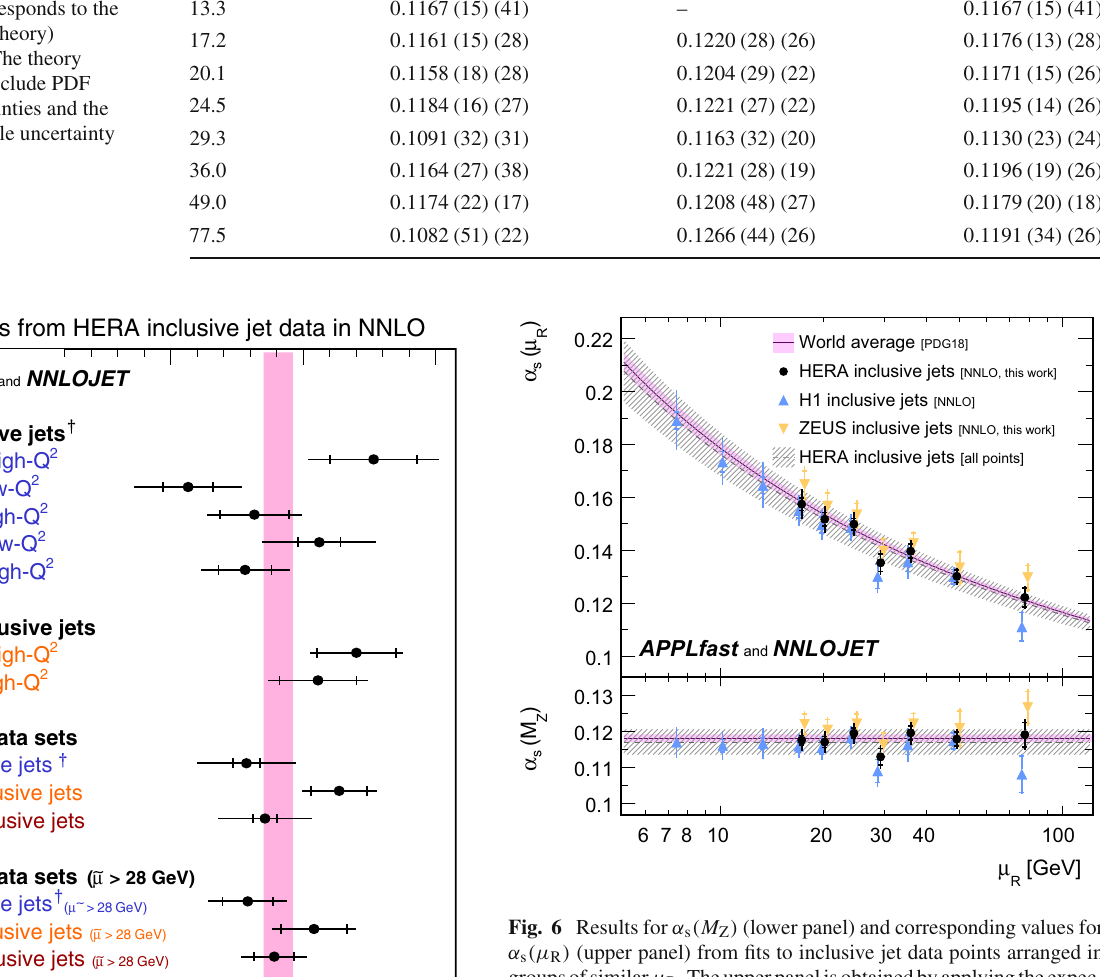
Ref.[1]andlieclosertotheworldaverage.Thedetermination of α s ( M Z ) from H1 and ZEUS data taken together